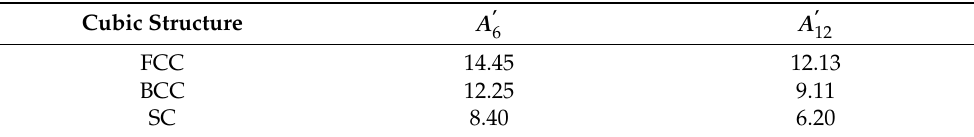
and A (cid:48) for different cubic structures 6 12